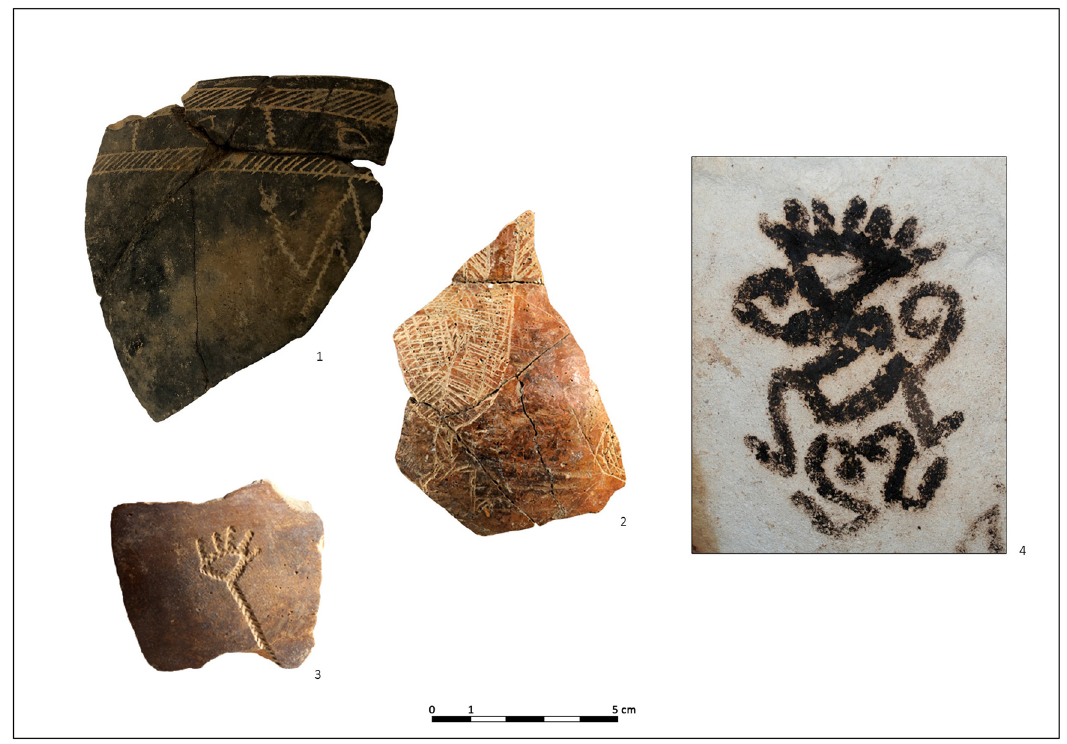
Figure 7: Vessels with whole - body representations from Grotta della Trinità ( 1 ) , Sant ’ Anna ( 2 ) , Samari ( 3 ) and the “ Shaman fi gure ” painted on the wall of Grotta dei Cervi ( 4 )